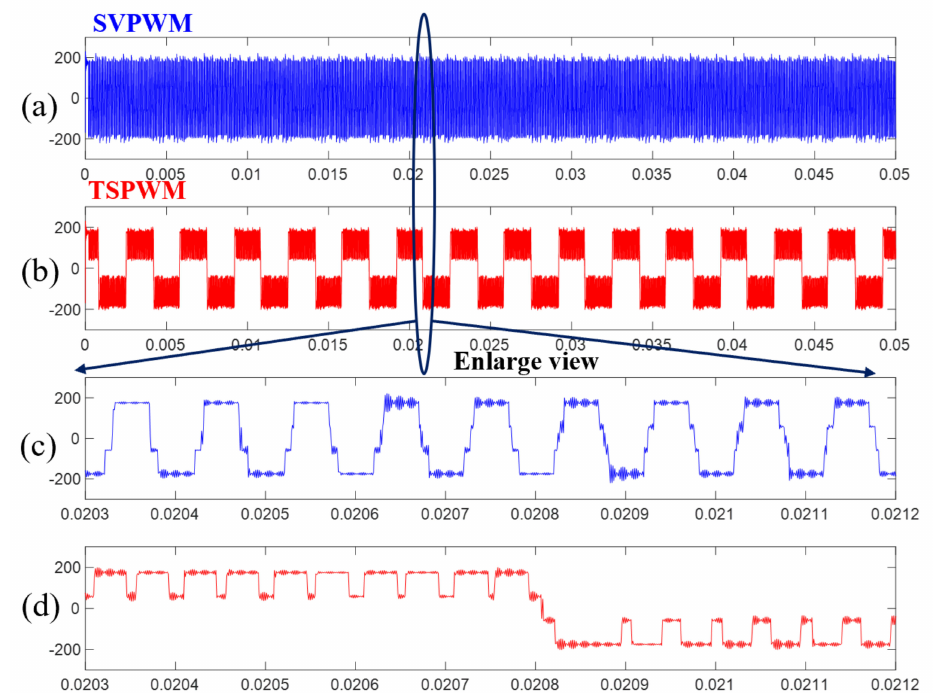
Figure 10. Comparison of common voltages with SVPWM and TSPWM in low modulation region (M = 0.2): ( a ) SVPWM; ( b ) TSPWM; ( c , d ) are the enlarge views of ( a , b ), respectively.